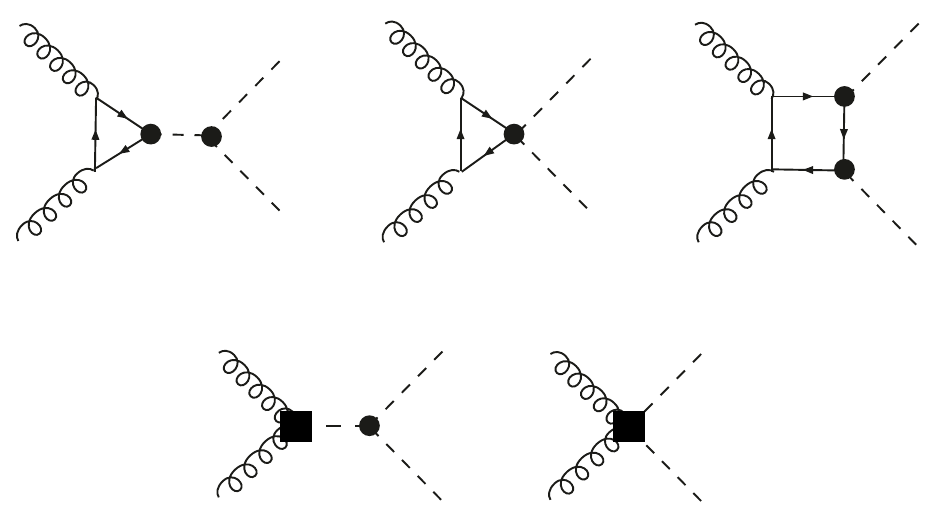
Figure 1. Higgs-pair production in gluon fusion at leading order in the chiral Lagrangian. The black dots indicate vertices from L 2 , the black squares denote local terms from L 4